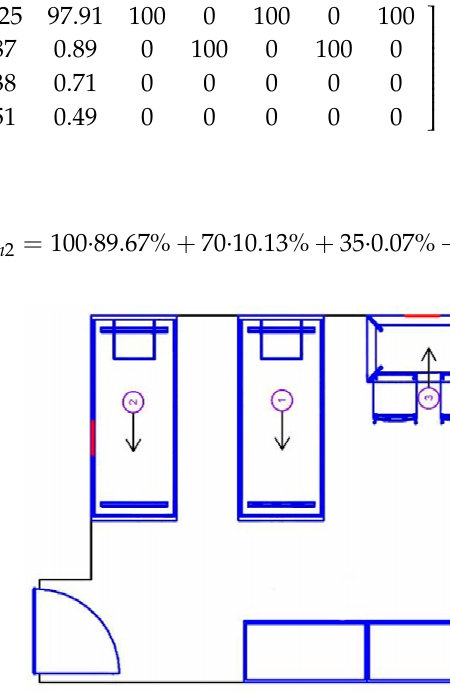
Figure 6. UGR evaluation in Bedroom 2: plan view. Figure 7. UGR evaluation in Bedroom 2: plan view.